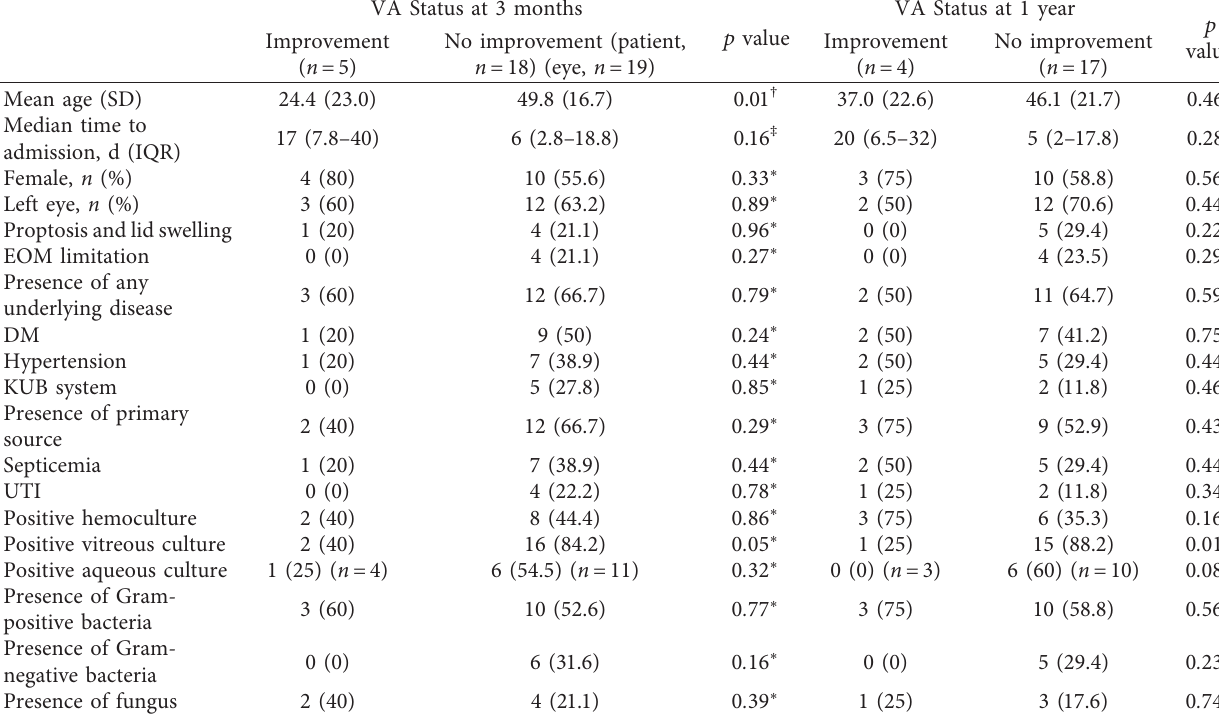
Table 3: Correlation between patient characteristics and visual